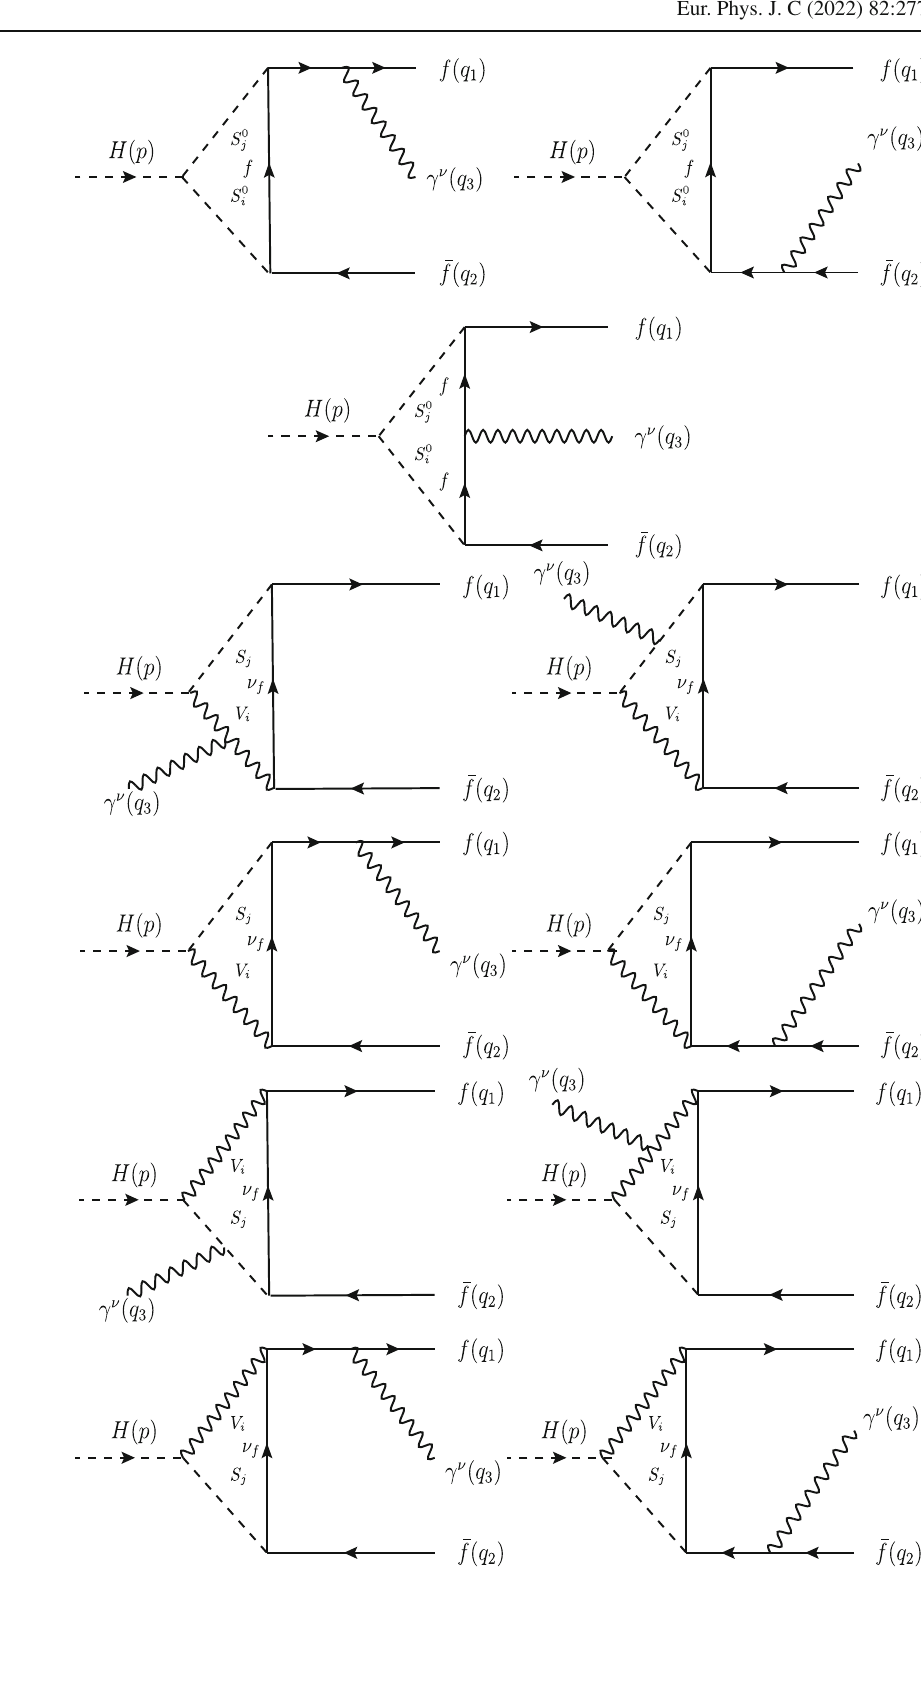
with exchanging vector boson V i and scalar boson S j particles in